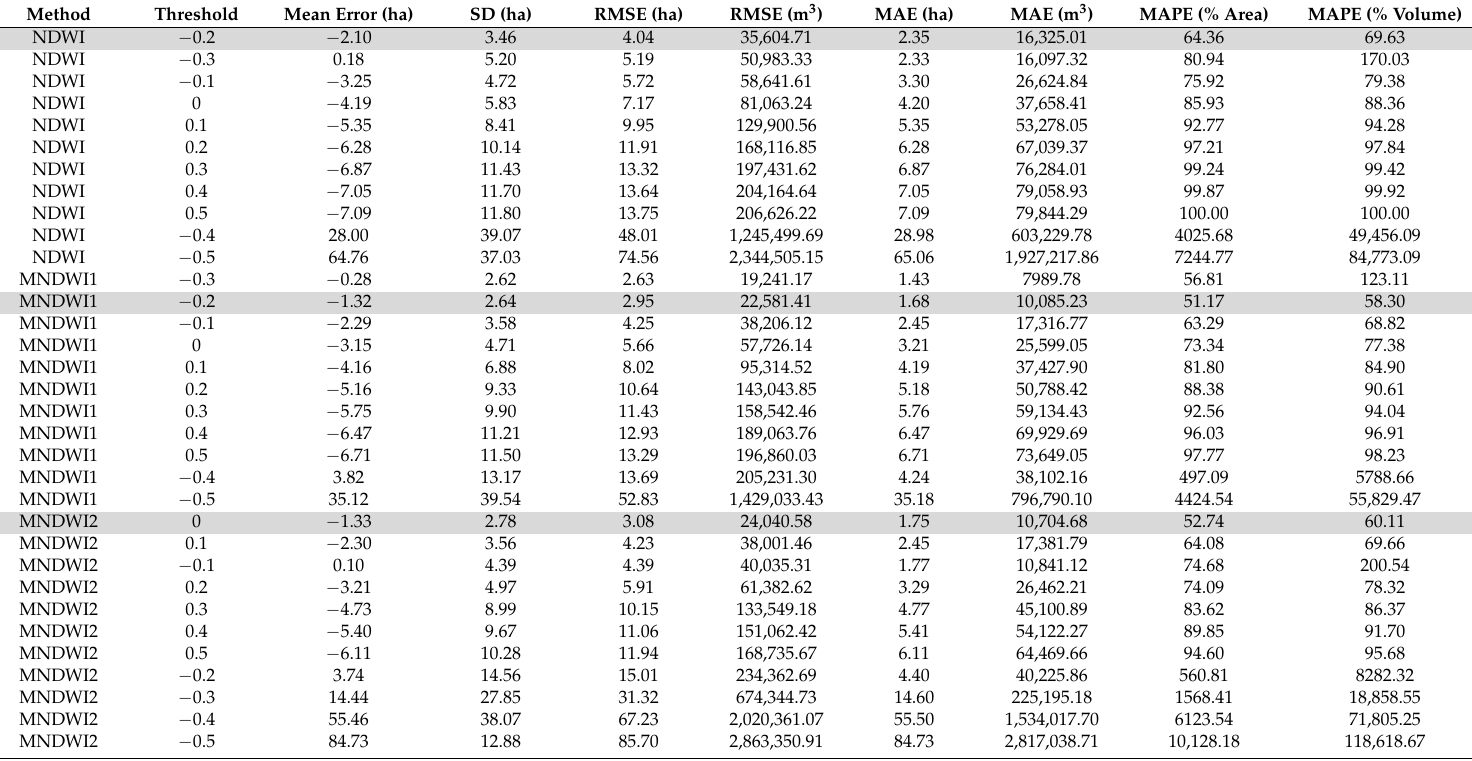
Table A1. Accuracy of reservoir area estimates (n = 272) derived from Landsat 8 OLI imagery across the 11 thresholds tested for NDWI, MNDWI1 and MNDWI2. Highlighted rows represent optimal thresholds, i.e., those with the lowest mean absolute percentage error for reservoir area